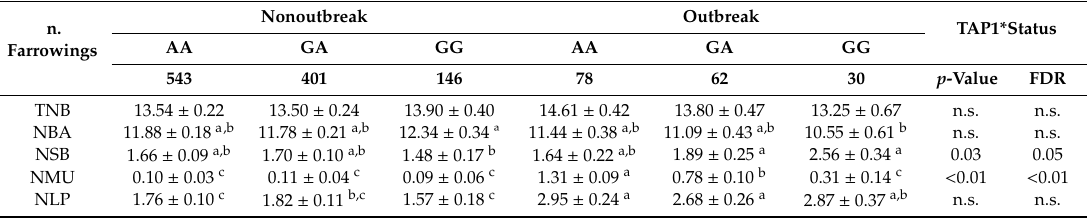
Table 5. Least square means ( ± SE) for reproductive traits by TAP1_rs80928141 genotype and farm health status. Significant interactions between genotype and the health status of the farm (TAP1*Status) are